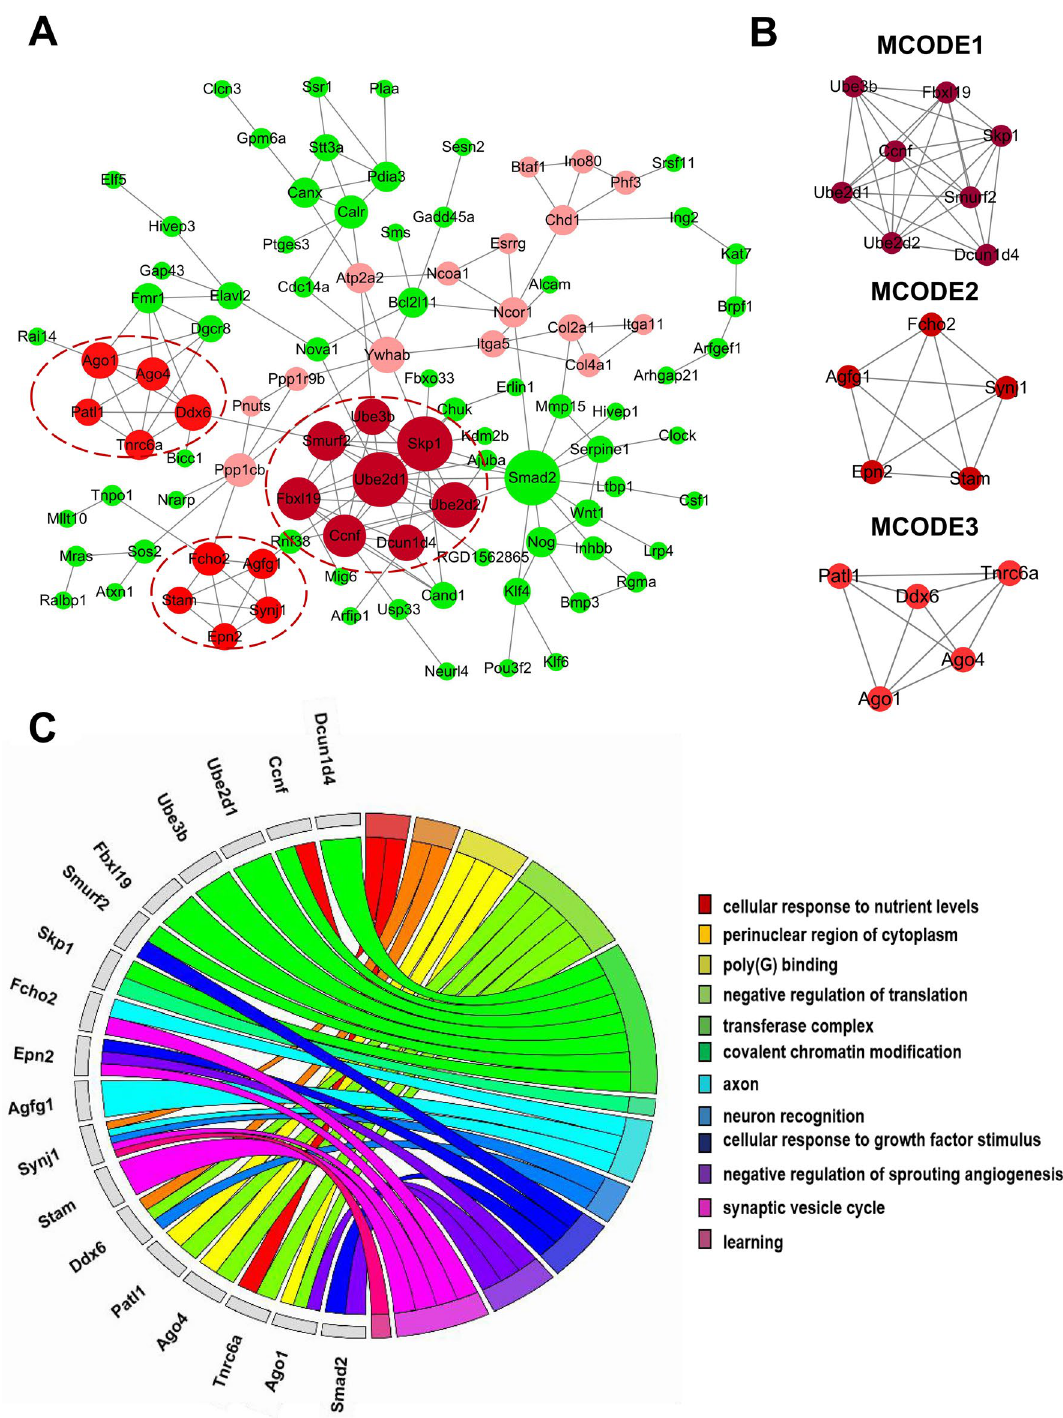
Figure 4. PPI network analysis and functional enrichment analysis of hub genes. ( A ) PPI network analysis. Circular nodes represent the miR-148a-3p target genes. Circular nodes in red represent the hub genes. A larger node size corresponds to more genes that are co-expressed with the gene. Darker colors indicate greater significance. ( B ) Three significant modules selected from the PPI network. Each node represents a protein. ( C ) GO enrichment analysis of 18 hub genes. Different color bands represent different GO